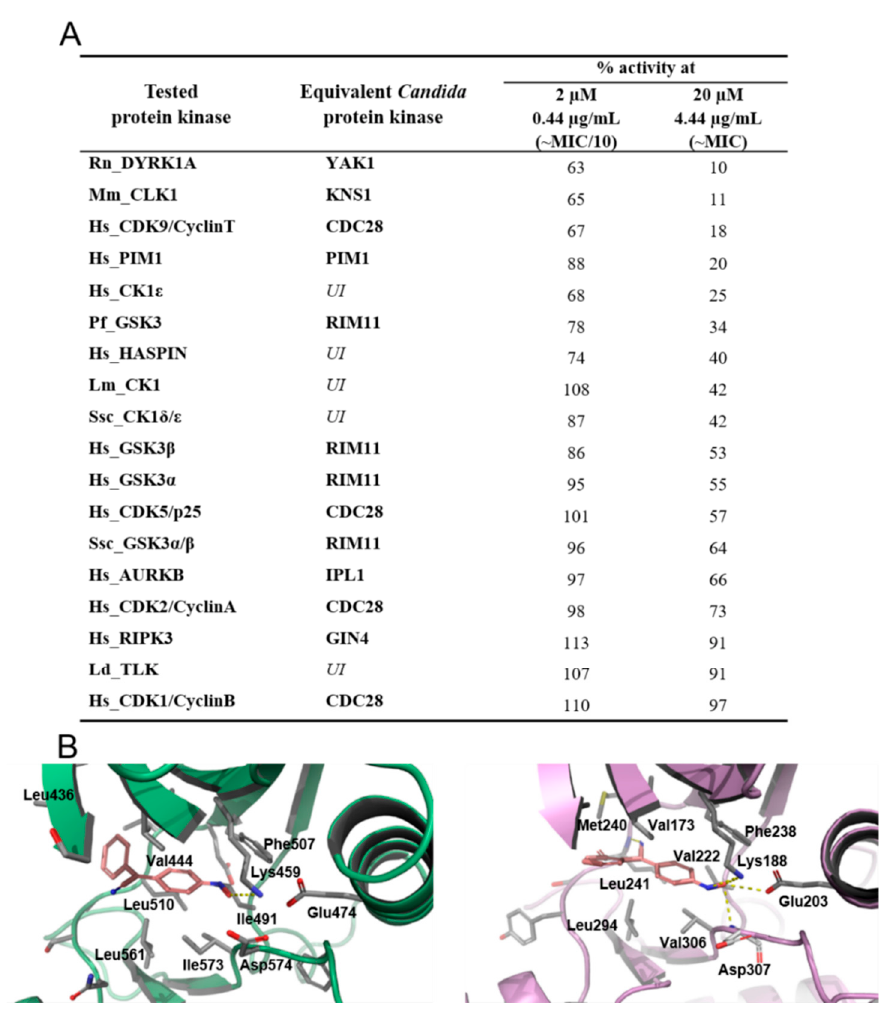
Figure 4. Effect of 4-AN on kinase activity. ( A ) Inhibitory activities of 4-AN against a short panel of disease-related protein kinases. The table displays the remaining kinase activities detected after treatment with 2 or 20 µM of 4-AN. Candida equivalents of the tested protein kinases were derived from the Candida Genome Database (http://www.candidagenome.org/) and ProViz tool (http://proviz.ucd.ie/), UI—Candida equivalent unidentified. Results are expressed in % of maximal activity, i.e., measured in the absence of inhibitor but with an equivalent dose of DMSO (solvent of the tested compounds). ATP concentration used in the kinase assays was 15 µ mol/L (values are means, n = 2). Kinases are from human origin unless specified: Rn, Rattus norvegicus ; Mm, Mus musculus ; Pf, Plasmodium falciparum ; Lm, Leishmania major ; Ssc, Sus scrofa domesticus ; Ld, Leishmania donovani . ( B ) Docked binding modes for 4-AN in the ATP-binding pocket of YAK1 ( left ) and DYRK1A ( right